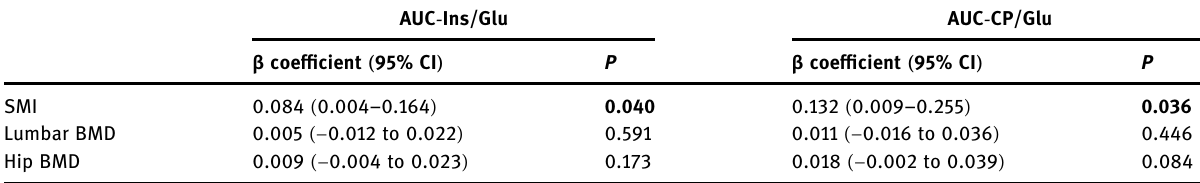
Table 3: Multiple linear regression analysis of β - cell function and musculoskeletal indices in T2DM